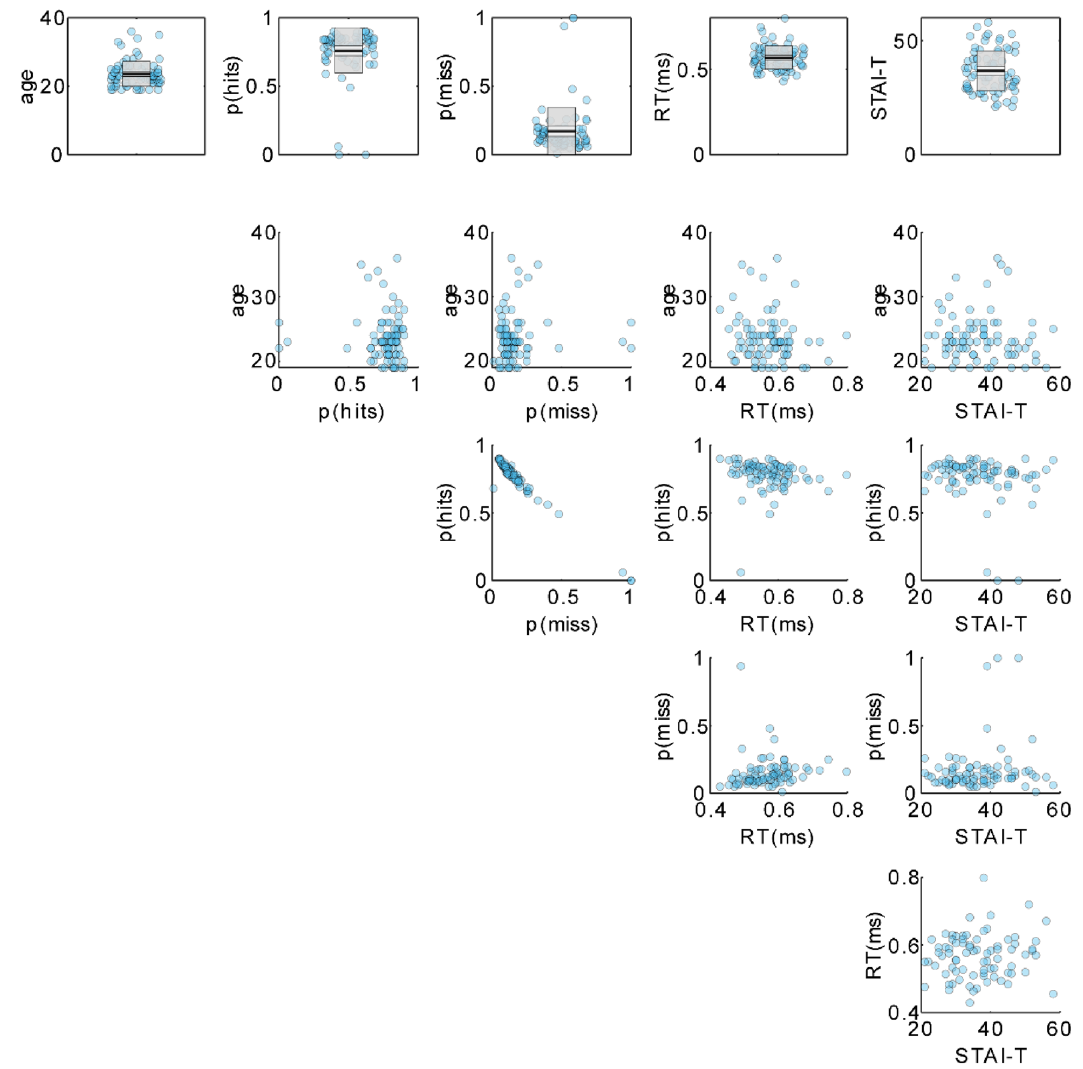
Figure 2. Demographic and behavioral data. Top row: univariate scatterplot of age, relative frequencies of hits and misses, average reaction times, and trait anxiety scores. Random jitter in x-direction was added to reduce cluttering. The superimposed gray boxes illustrate ± 1 standard deviation (SD; dark gray) and ± 1 standard error of measurement (SEM; light gray) around the mean (black line). Rows 2 to 5 contain scatterplots of each pairwise combination of these